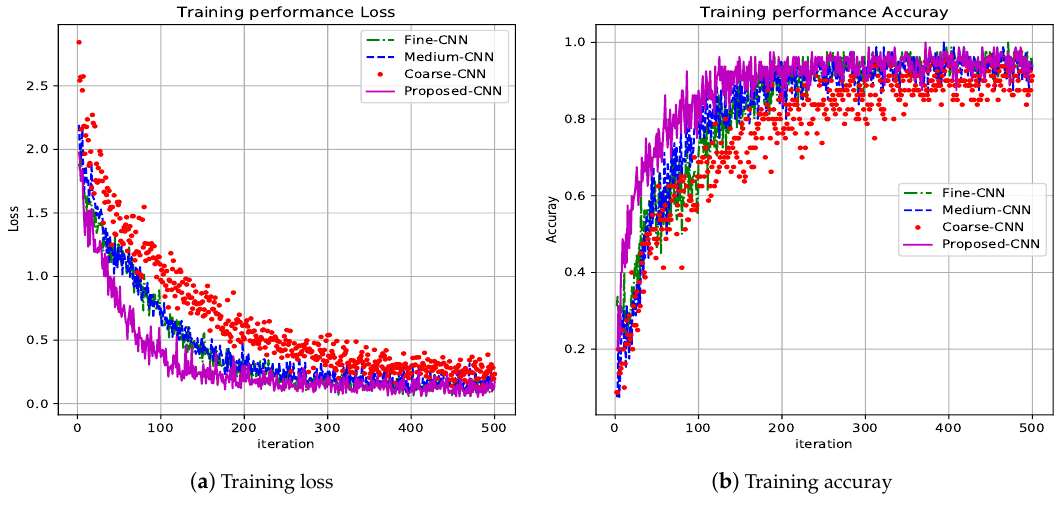
Figure 5. Training results for the proposed CNN architecture.